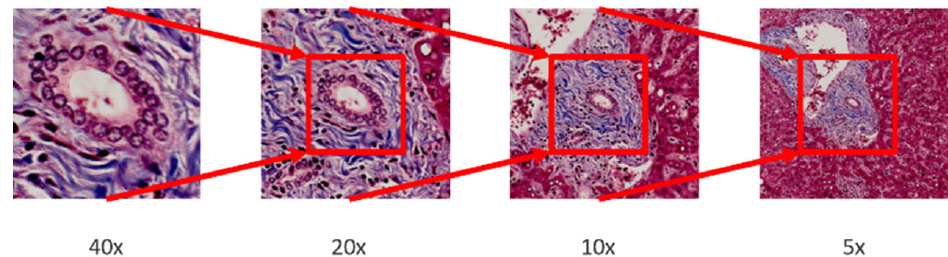
Figure 3. Patches from different magnifications. The higher magnification patch is located in the central region of the lower magnification patch.